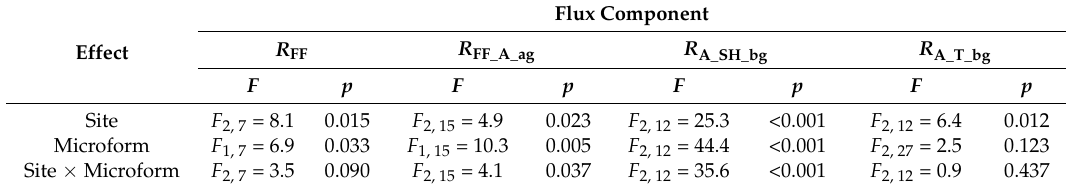
Table 2. Statistical results of repeated, linear mixed effects models. The models tested the fixed effects of site and microform on respiration of forest floor (R FF ), aboveground autotrophic respiration of forest floor (R FF_A_ag ), and belowground autotrophic respiration of shrubs + herbs and trees (R A_SH_bg and R A_T_bg , respectively), separately *.